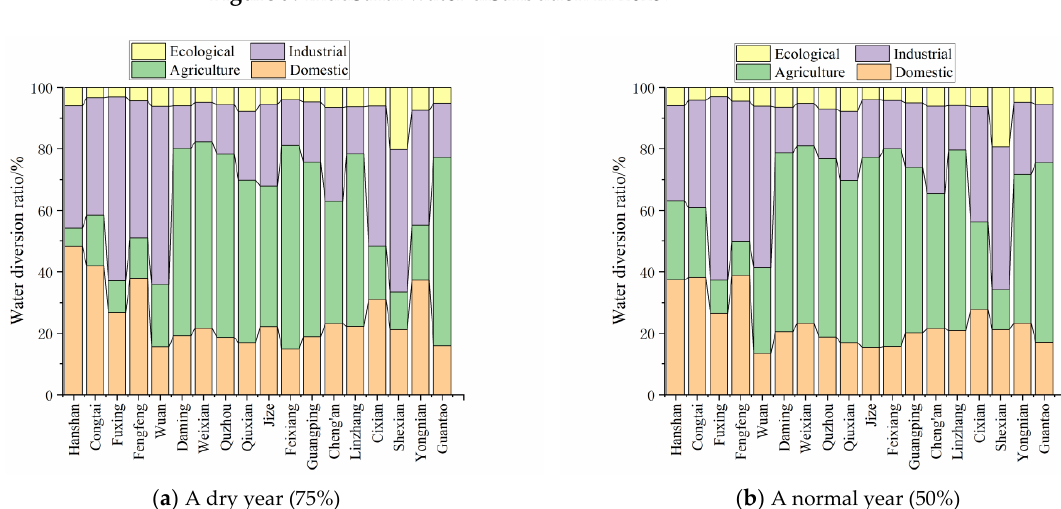
Figure 10. Industrial water distribution in 2035.